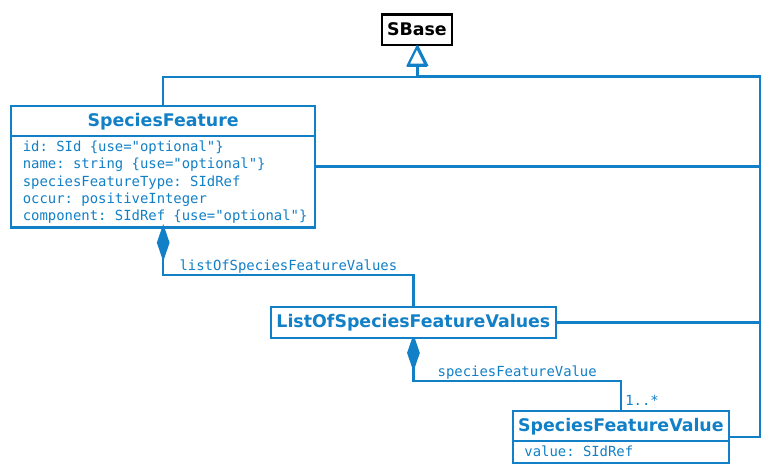
Figure 12: The definitions of the SpeciesFeature class and the SpeciesFeatureValue